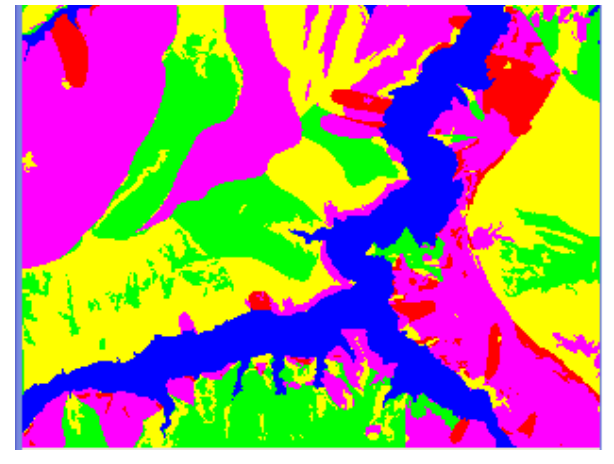
Figure22. Forecast result of Information Content